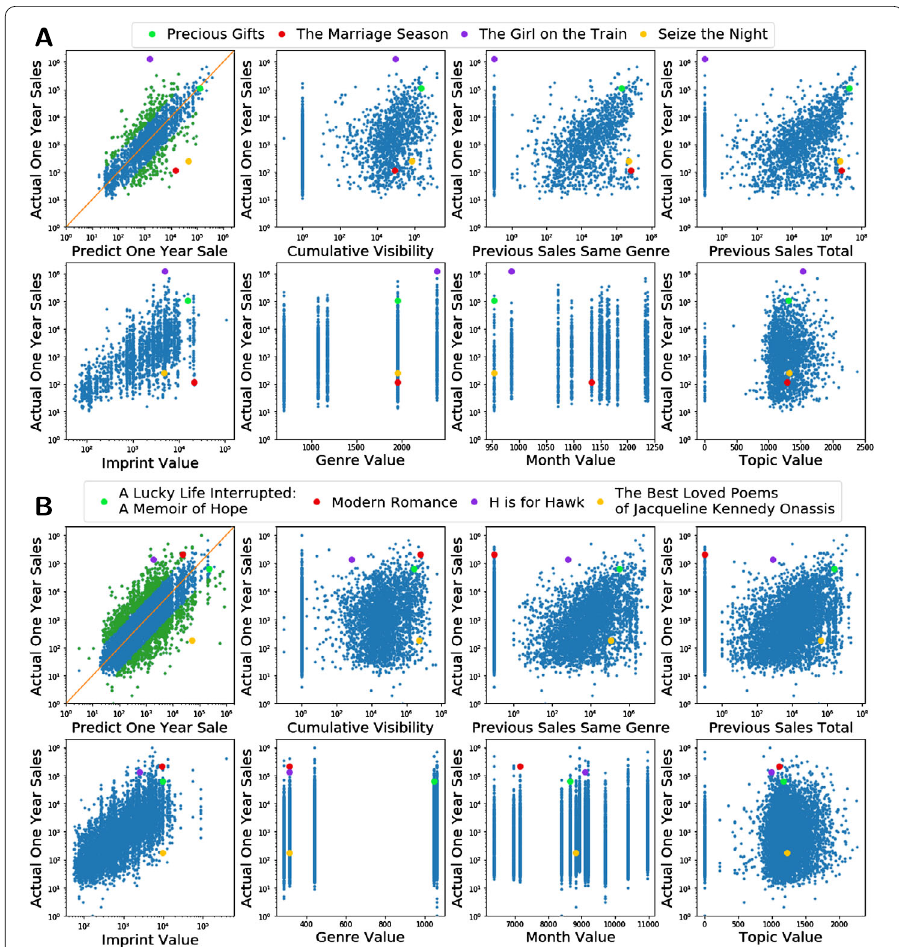
Figure 11 Case Studies for ( A ) fiction and ( B ) nonfiction books. In the top left scatter plot, dots are colored green if the z-score of error (log(predict)–log(true)) is more than 2 standard deviations away from the average